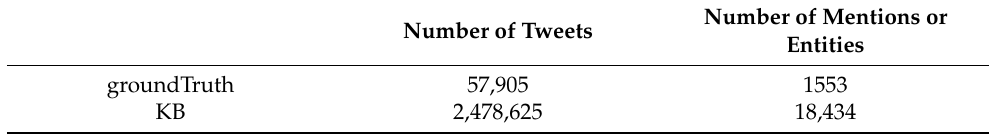
Table 1. Statistics of our reconstructed dataset and knowledge base.